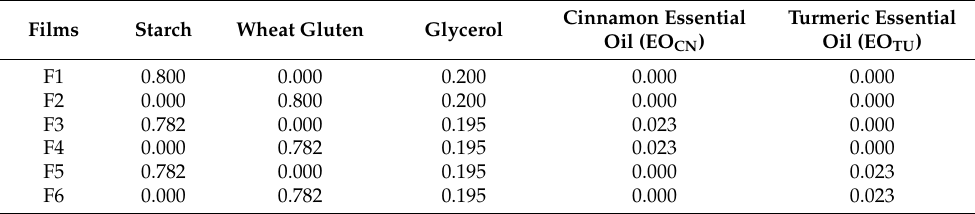
Table 1. Experimental design expressed in mass